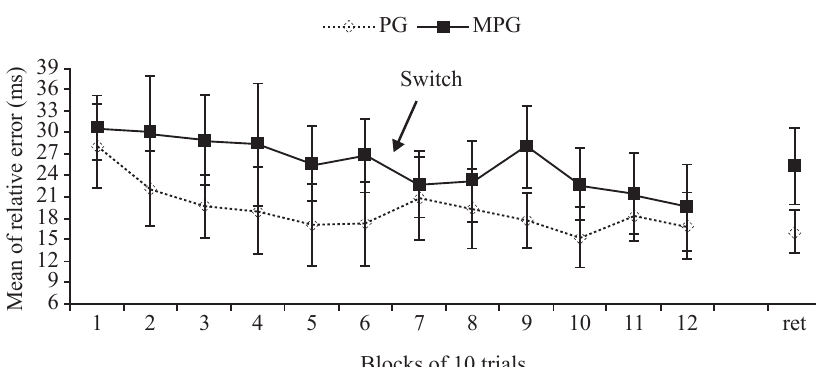
Figure 1. Mean of relative error in the acquisition phase and in the retention test. The vertical bars denote the confidence interval in 95%